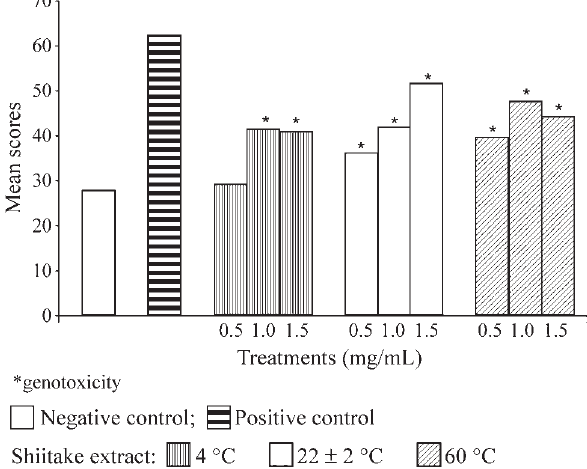
Figure 1 - Evaluation of genotoxicity by the Comet assay after treatment of HEp-2 cells with three aqueous extracts of shiitake (0.5, 1.0 and 1.5 mg/mL) prepared at three different temperatures (4, 22 ± 2 and 60 °C). Data represents Comet assay mean